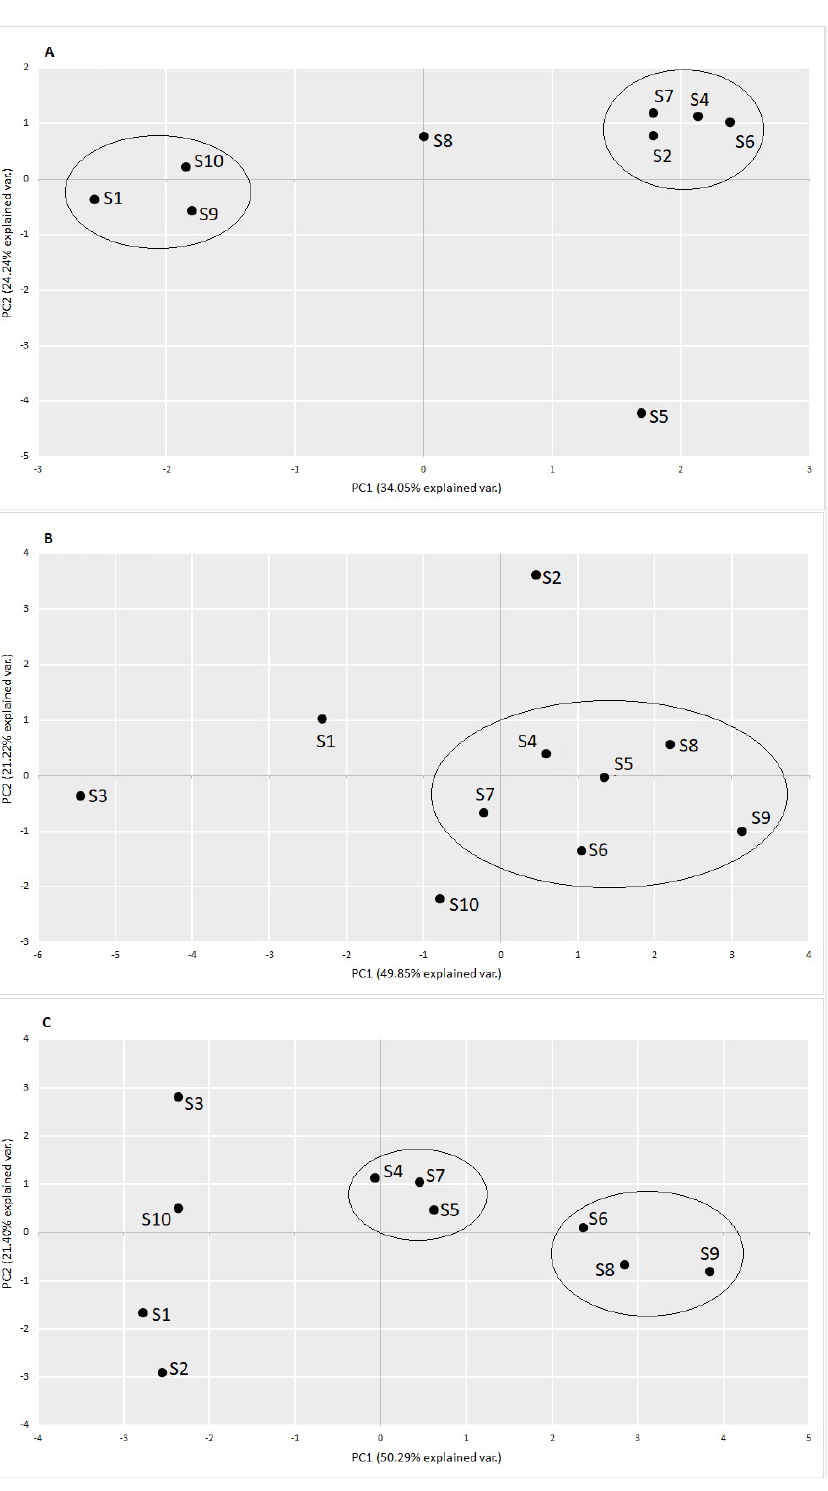
Figure 4. Principal component analysis (PCA) of the samples collected from different technological steps in various seasons on the variance-covariance matrix of the relative abundances of pathogens from the WHO multi-resistant pathogens list. The numbers in brackets describe the percentage of variance, explained by the first two components. ( A ) summer 2018; ( B ) autumn 2018; ( C ) spring 2019.